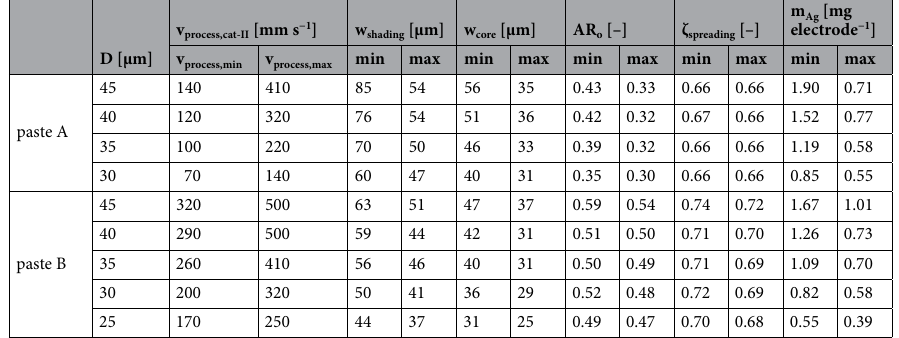
Table 1. Overview of process velocity ranges (category II) and resulting line shapes and Ag laydowns of low-temperature pastes A and B when dispensing the high-viscous suspensions through nozzle diameters of D = 25 µm to D = 45 µm.